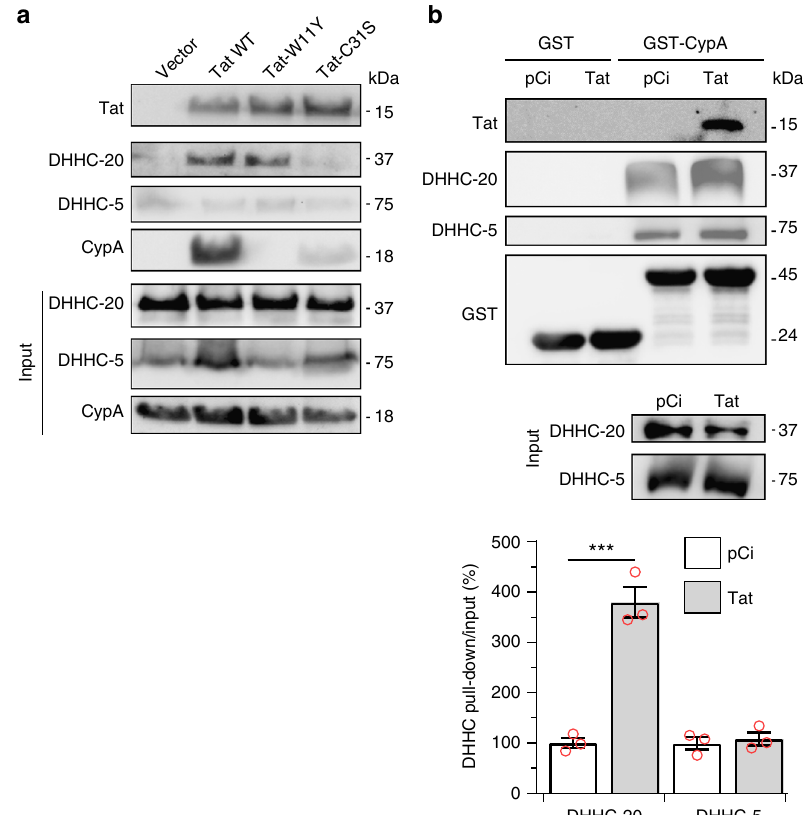
Fig. 7 Tat interacts with CypA and DHHC-20. a HEK 293 T cells were transfected with an empty vector or Tat-FLAG (WT, 31 S, or 11Y). Cells were lysed 48 h after transfection before anti-FLAG immunoprecipitation and western blots against CypA, DHHC-5 and DHHC-20. b Cells were transfected with an empty (pCi) or Tat vector. GST or GST-CypA was added to cell extracts for GST pull-down before western blots. The graph shows the quanti fi cation of the DHHC pulled-down/input intensity ratio, setting the empty vector ratio to 100%. Representative data (mean ± SEM, n = 3 independent experiments) are shown.*** p < 0.001 (Student ’ s t -test between Tat and